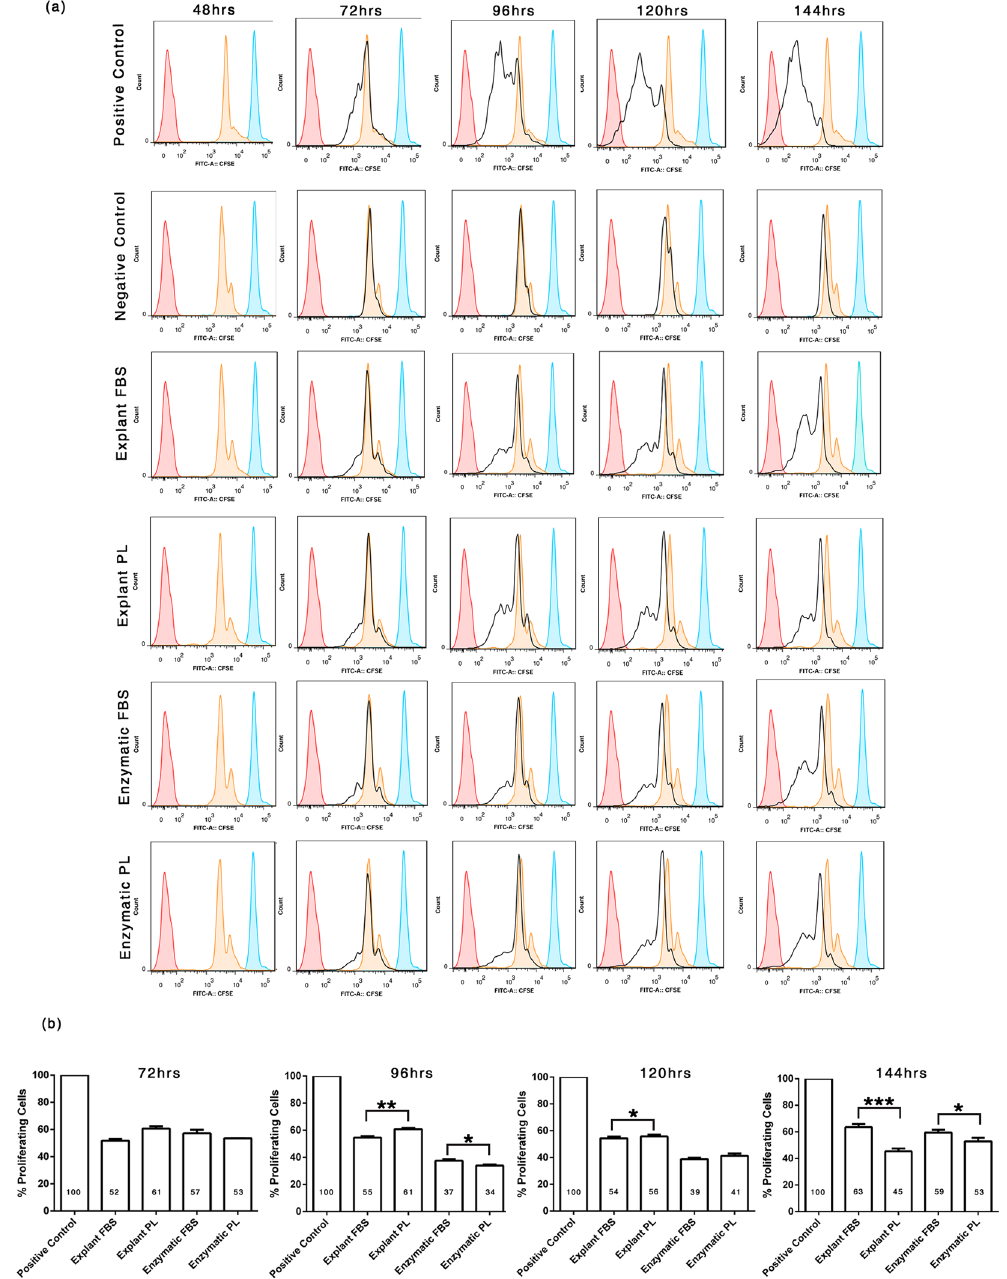
Figure 7. CFSE-based lymphocyte proliferation assay. ( a ) Flow cytometry analysis exhibited several histograms representing unstained lymphocytes at 0 h (represented by pink histogram), CFSE stained lymphocytes at 0 h (represented by blue histogram), CFSE dilution peak (represented by orange histogram) and proliferation of stained lymphocytes with respect to CFSE expression level (represented by black histogram). When the lymphocytes proliferate, new peaks moving towards the left of the initial peak with reduced dye intensity is seen. ( b ) Percentage of proliferating lymphocytes co-cultured with MSCs were normalized with control from the CFSE dilution peak. Statistical comparisons were made within the explant and enzymatic groups respectively over different time points using student’s t test. * P < 0.05, ** P < 0.01, *** P <